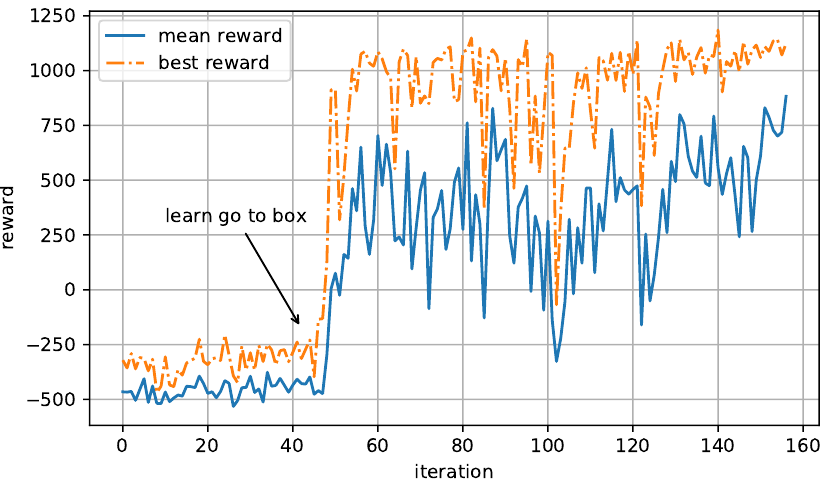
Figure 6. Policy training using the CMA-ES. The average and maximum reward of the learned behavior for each iteration are shown. Each iteration includes 16,800 simulation steps. The point at which the swarm has learned to move the food box correctly is